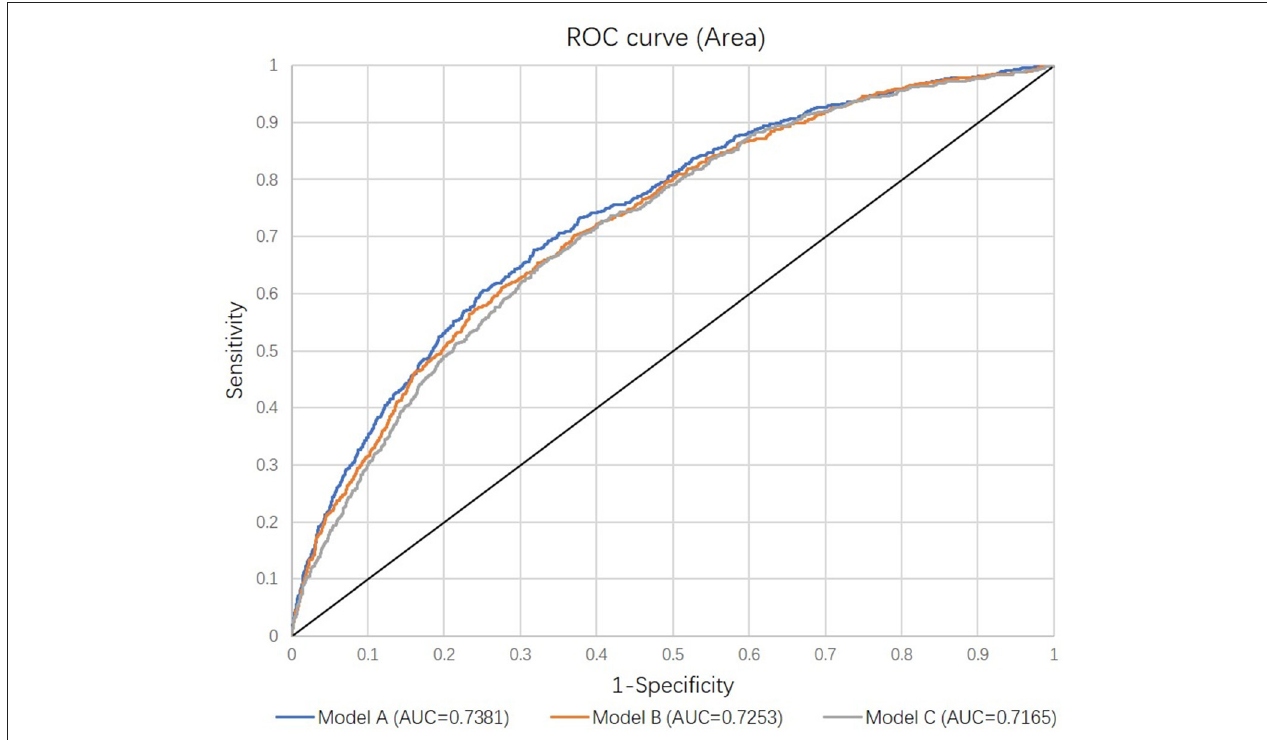
FIGURE 2 | Receiver Operating Curves comparing the discrimination of the three models. Each model was adjusted for randomly assigned treatments. See details in Methods.